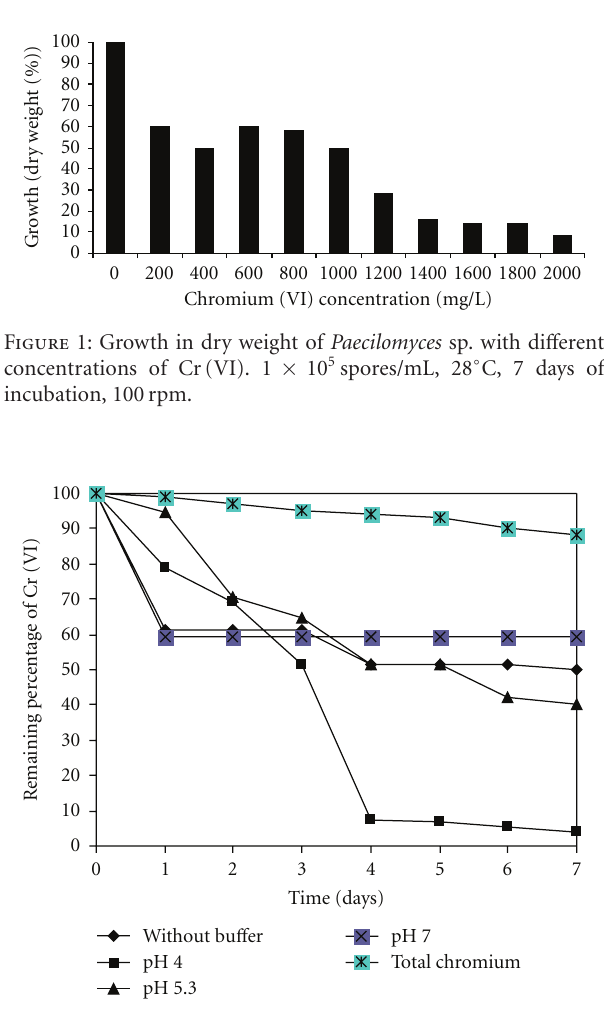
Figure 2: The e ff ect of pH on Chromium remotion by Paecilomyces sp. 50mg/LCr(VI), 100 rpm, 28 ◦ C.